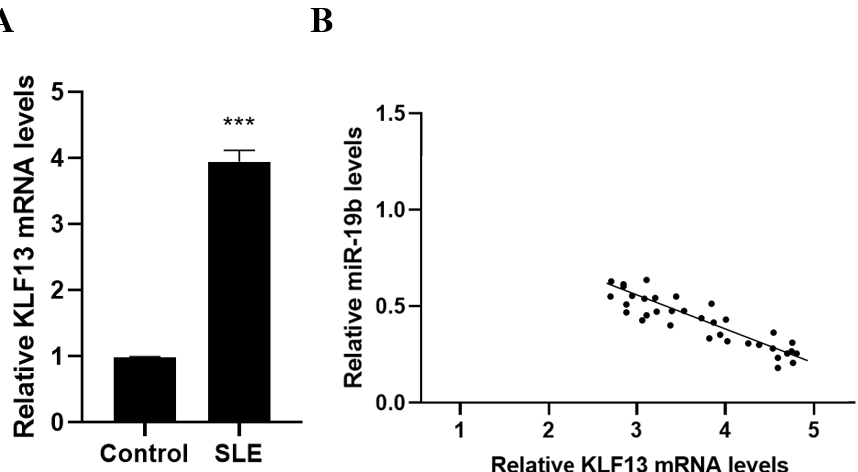
Figure 3. miR-19b targets KLF13 expression. ( A ) Bioinformatics website analysis of the binding site of KLF13 3’-UTR to miR-19b, ( B ) dual luciferase reporter gene to identify miR-19b and KLF13 binding, ( C ) Western blot analysis of several transfections protein expression of post-KLF13. Compared with NC mimics group. ** p < 0.01.